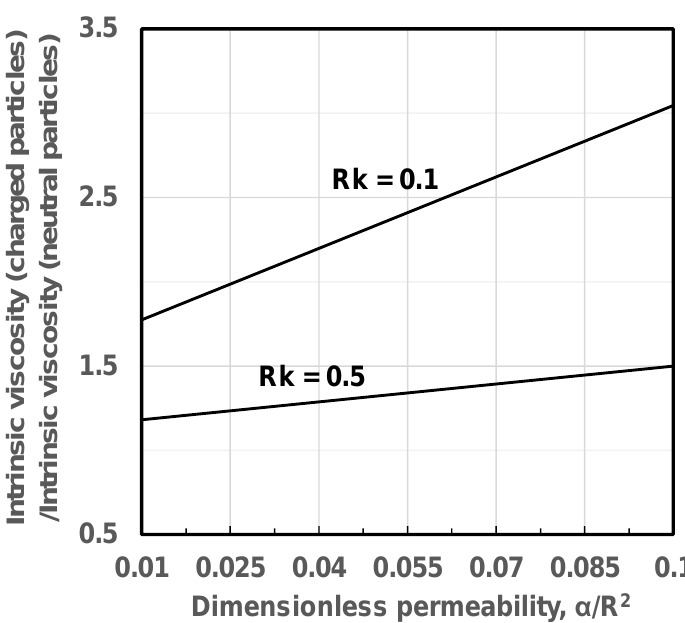
Figure 12. Influence of particle permeability on the intrinsic viscosity of suspension of electrically-charged porous particles.